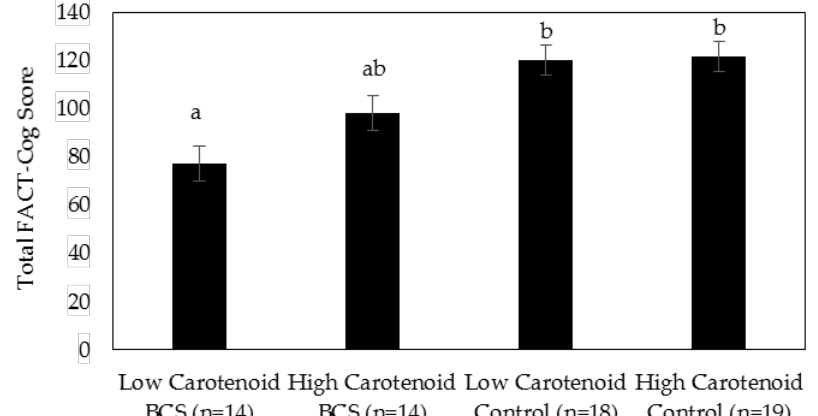
Figure 1. Perceived Cognitive Dysfunction by Group Carotenoid Status. Data are adjusted mean (standard error). ANCOVA with age as covariate. Different letters indicate significant differences between groups ( p < 0.05).